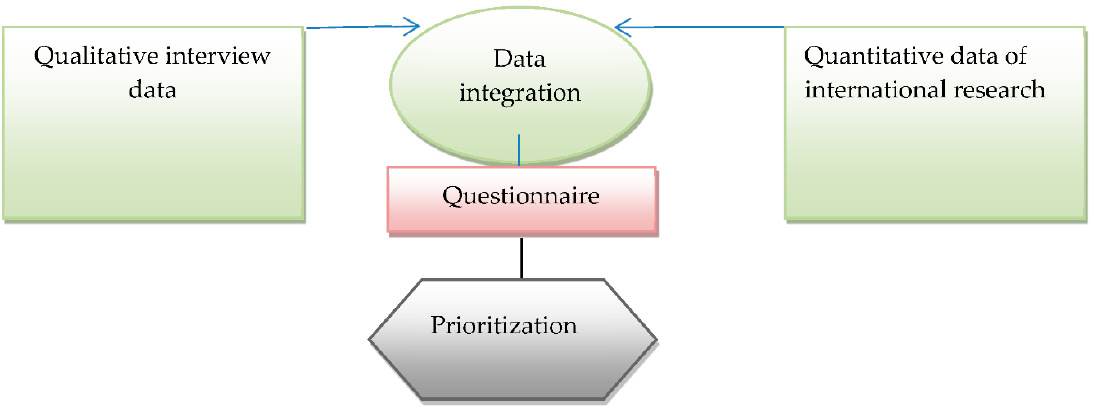
Figure 1. Data integration